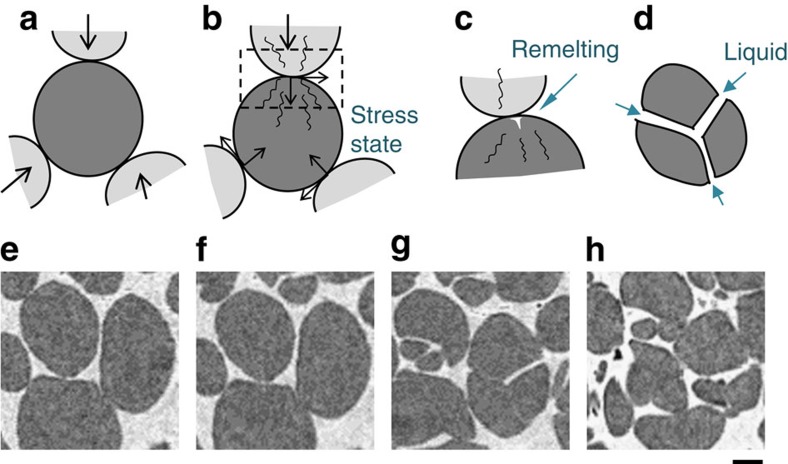
Mechanism of transgranular liquation cracking.(a–d) 2D schematic of the four stages: (a) motion and pinning of grains resulting in compressive and shear loads; (b) straining and dislocation movement under a stress state; (c) possible remelting and interface perturbation (shown for only one contact); and (d) crack growth from the surface of the grain accelerated by liquid entrainment. (e–h) Region of interest from Fig. 1b–e (yellow dotted circle) where transgranular fracture of single-crystal grains is occurring. Scale bar, 150 μm.